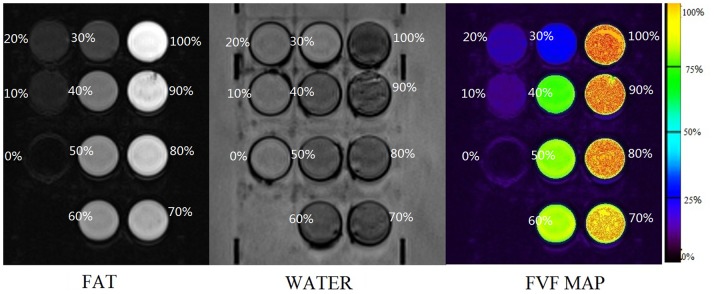
Results of phantom experiment.The bottle on the lower left side is filled with pure water (fat content: 0%), and the upper right one is filled with 100% peanut oil, while others have fat content ranging from 10% to 90% in sequence. In the fat phase image, the higher the fat content is, the higher signal intensity can be seen. But in water phase, the signal intensity of each bottle turned opposite to that of fat phase. The fat volume fraction (FVF) map demonstrates clear differences for different amounts of fat and water through the change of color.